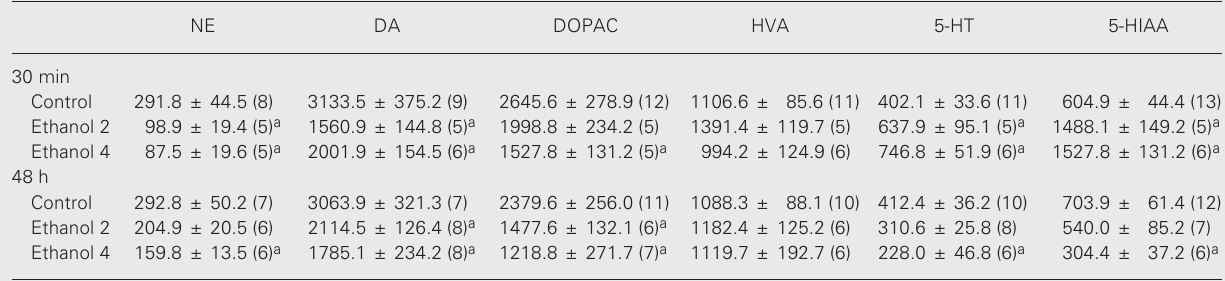
Table 2. Effects of chronic ethanol treatment on the concentrations of monoamines and metabolites in the rat